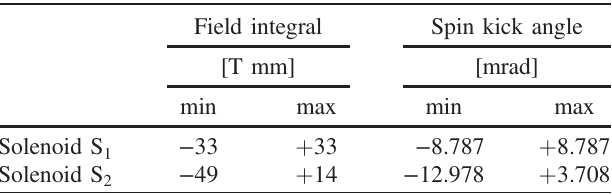
in the time s 1